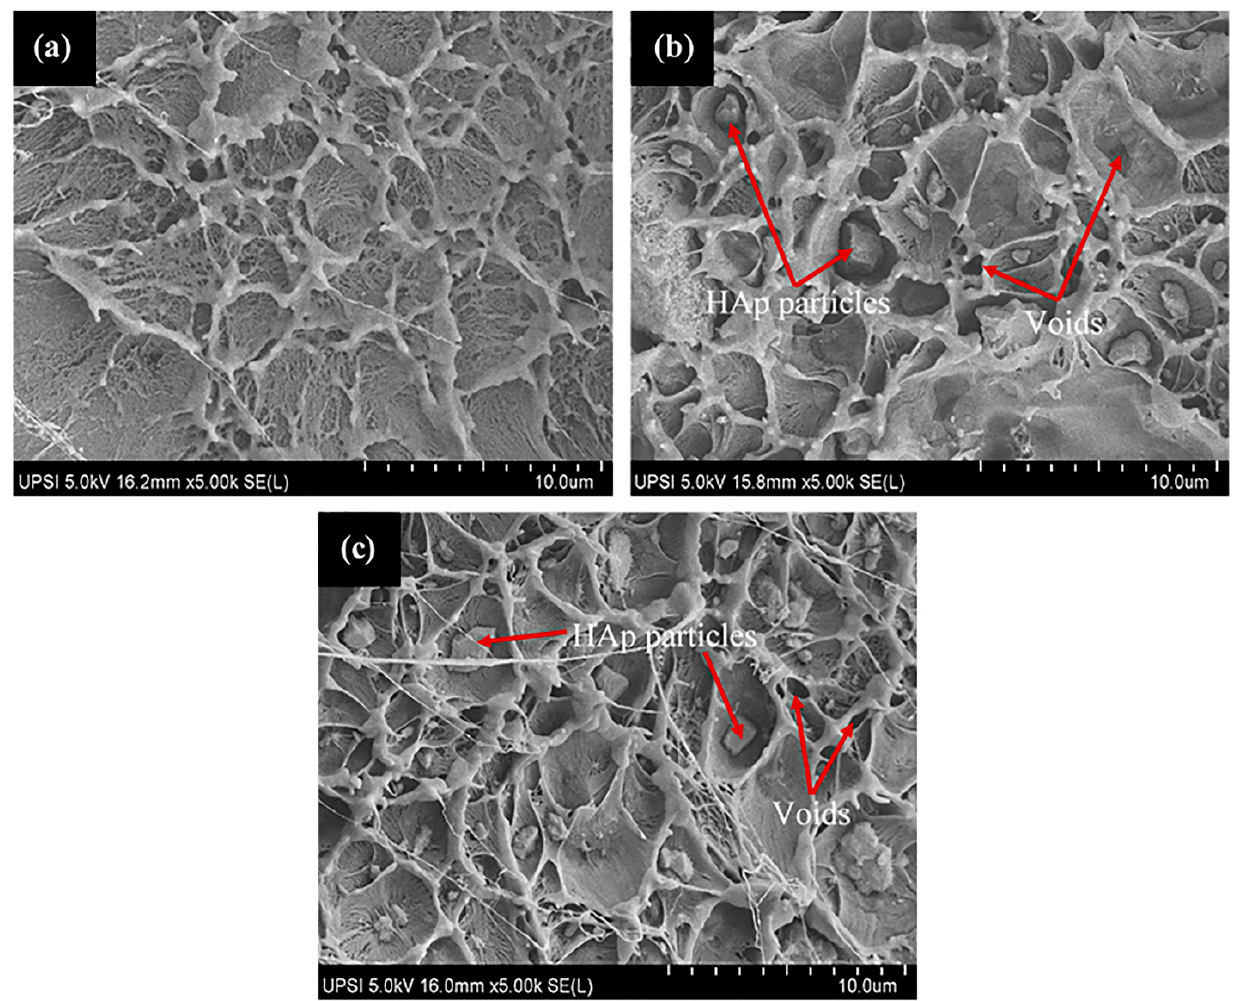
Figure 9. SEM images for the fracture surfaces of the ( a ) pure HDPE, ( b ) HDPE/30HAp, and ( c ) HDPE/30HAp-S composites subjected to impact strength test.